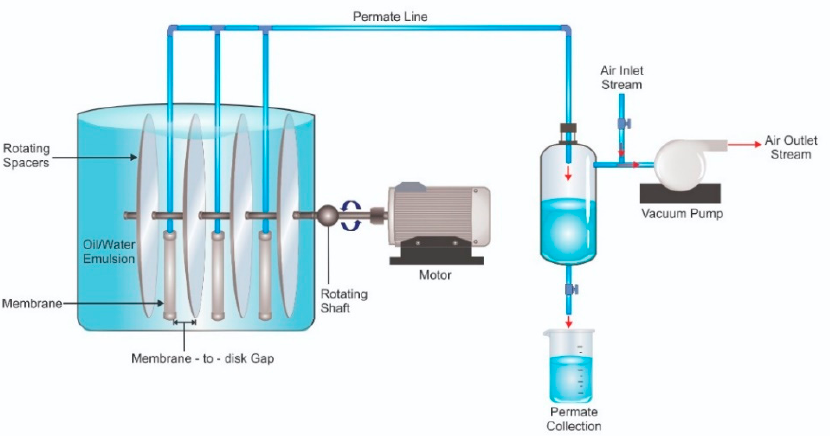
Figure 1. Illustration of laboratory-scaled rotating spacer submerged membrane filtration system. In the actual set-up, the single panel had a half-round shape and membrane sheets with total surface area of 0.2 m 2 were glued on both sides of the